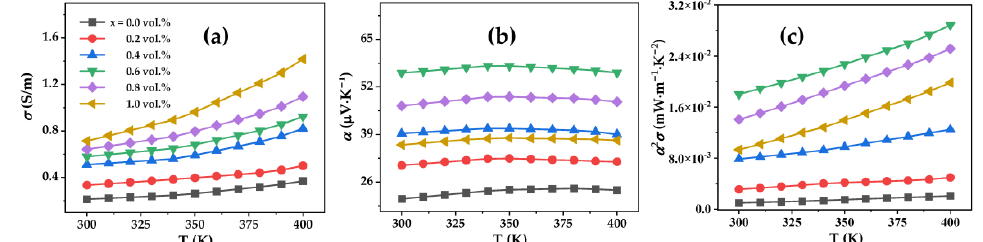
Figure 6. Temperature dependences of ( a ) electrical conductivity, ( b ) Seebeck coefficient, ( c ) power factor for the Bi 0.5 Sb 1.5 Te 3 /CNTs cement composites.